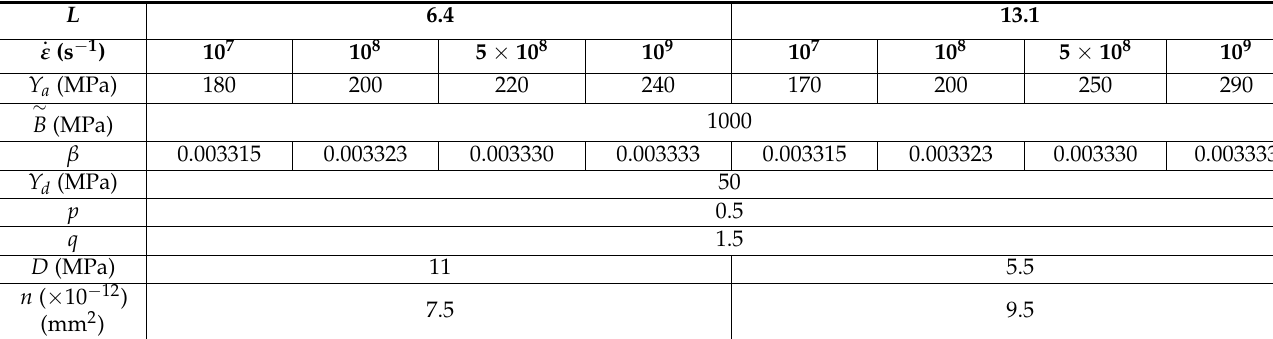
Table 4. Equation (10) parameter